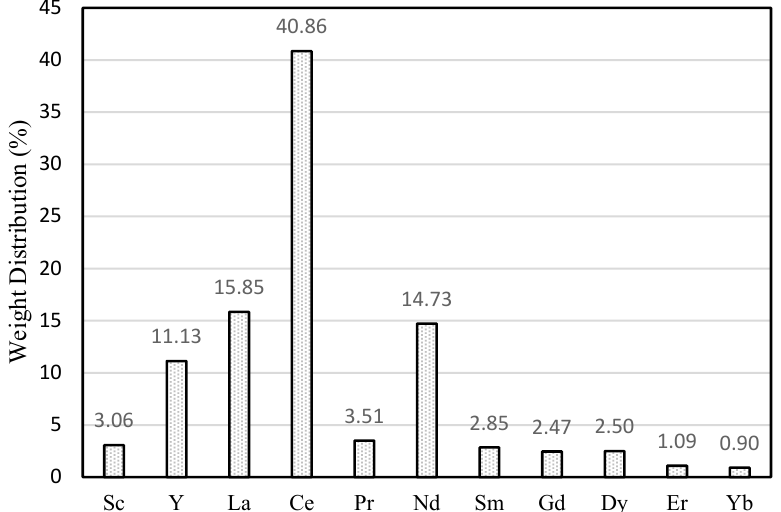
Figure 1. Rare earth element distribution in the nominal 1.4 × 1.6 Specific Gravity (SG) middling fraction of Fire Clay coal as collected from a secondary dense medium vessel product stream.